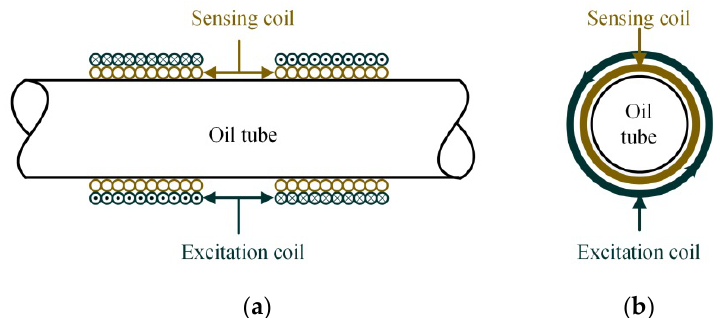
Figure 1. The structure of the new designed inductive debris sensor: ( a ) the front view of the sensor; ( b ) the side view of the sensor.